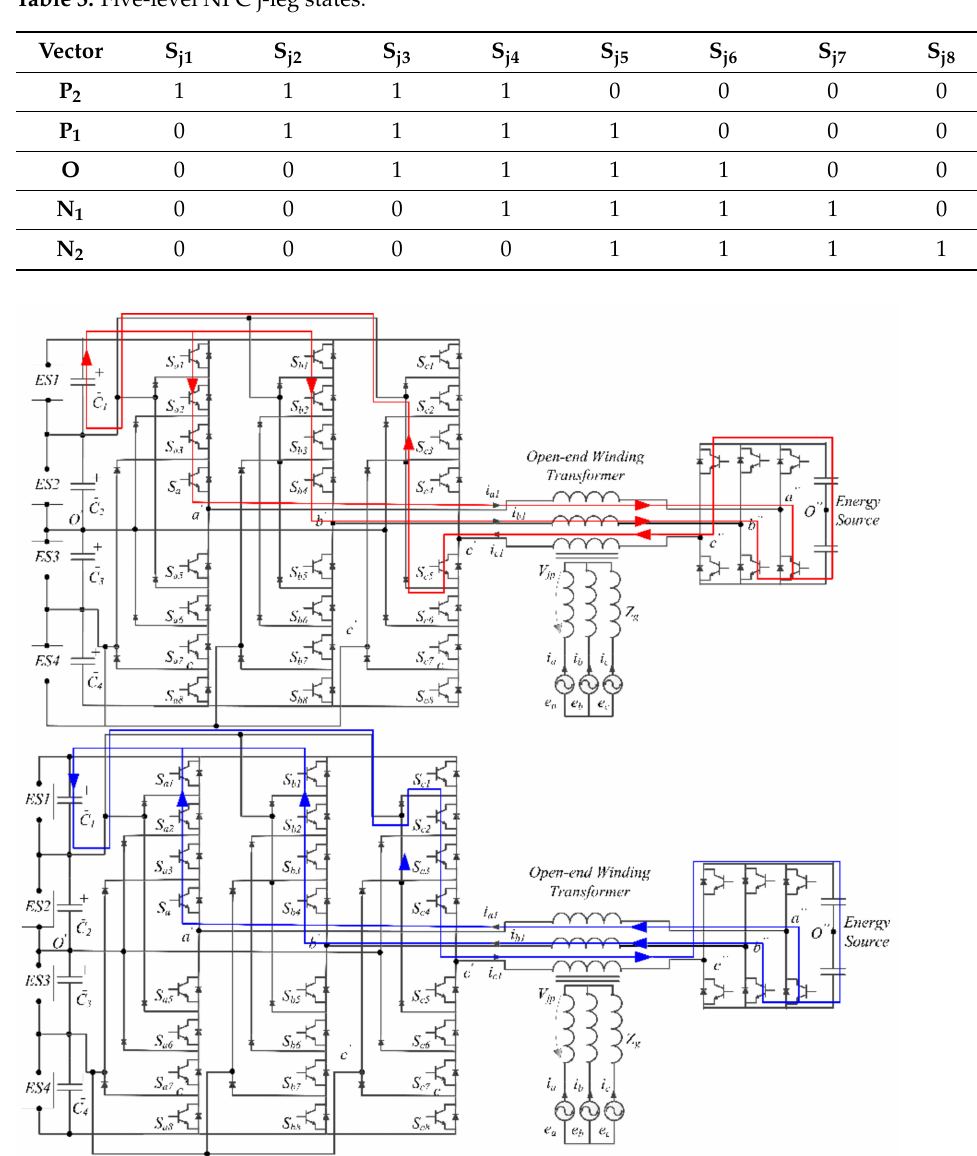
Figure 7. Five-level inverter (5LI) + TLI: C 1 voltage control when the P 2 P 2 P 1 vector is generated: (up) discharging; (down)